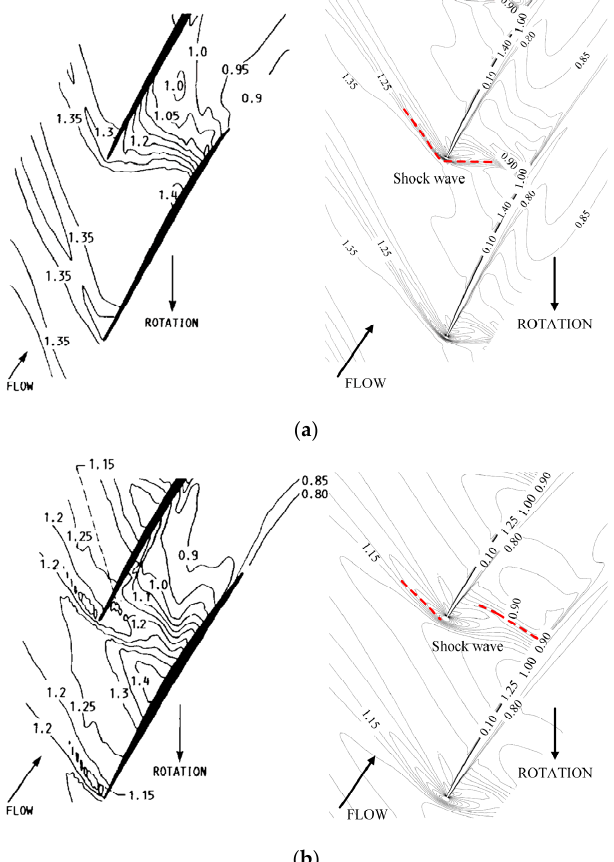
Figure 5. Relative Mach number distribution of the experimental [33] and CFD results: ( a ) 90% span of the experimental (left) and simulated (right) results; ( b ) 70% span of the experimental (left) and simulated (right) results. Red dotted line is to denote the shock wave.